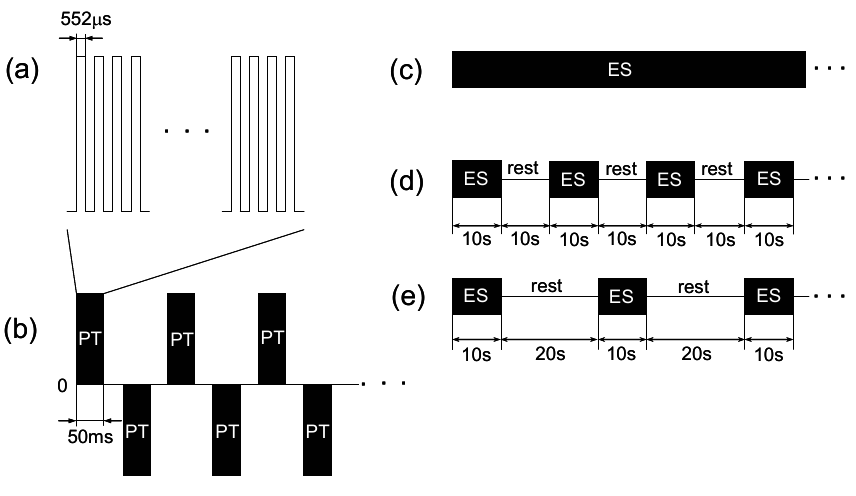
Fig. 1 Electrical stimulation signals. (a) Pulse train (PT) of electrical signal. (b) Electrical stimulation signal (ES) composed of cyclic bipolar PTs of 50 ms and varied interval times, producing stimulation (PT-repetition) frequency of 2, 5, 10, or 20 Hz. (c) Continuous stimulation without rests. (d) Intermitted stimulation with 10s-ESs and 10s-rests. (e) Intermitted stimulation with 10s-ESs and